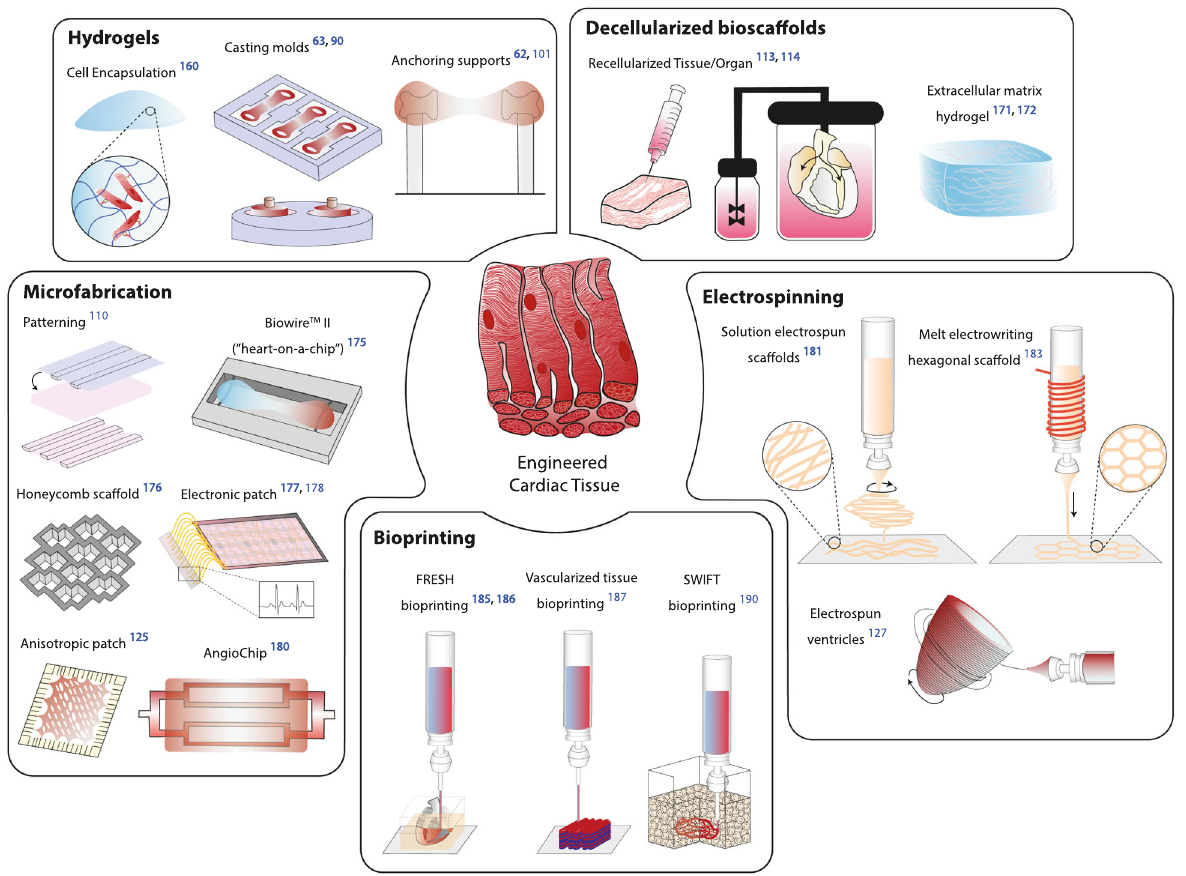
Fig. 3 Overview of state-of-the-art biomimetic cardiac tissues and corresponding fabrication approaches. Engineered cardiac tissues range from hydrogels capable of encouraging muscle fi ber organization, decellularized scaffolds for tissue/organ bioengineering, microfabricated systems for promoting tissue anisotropy and vascularization, electrospun fi bers for close mimicry of tissue architecture, and even printable tissue/miniaturized organs. FRESH Freeform Reversible Embedding of Suspended Hydrogels, SWIFT Sacri fi cial Writing Into Functional